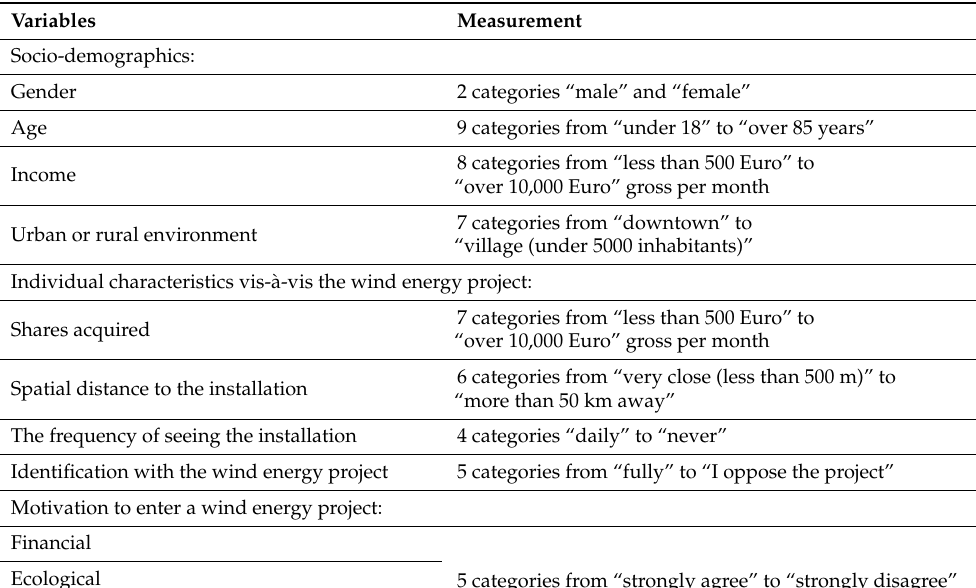
Table 1. Overview of questions regarding demographics and the